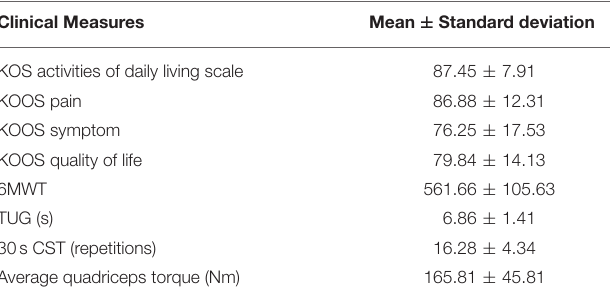
TABLE 2 | Mean and standard deviation of clinical measures.